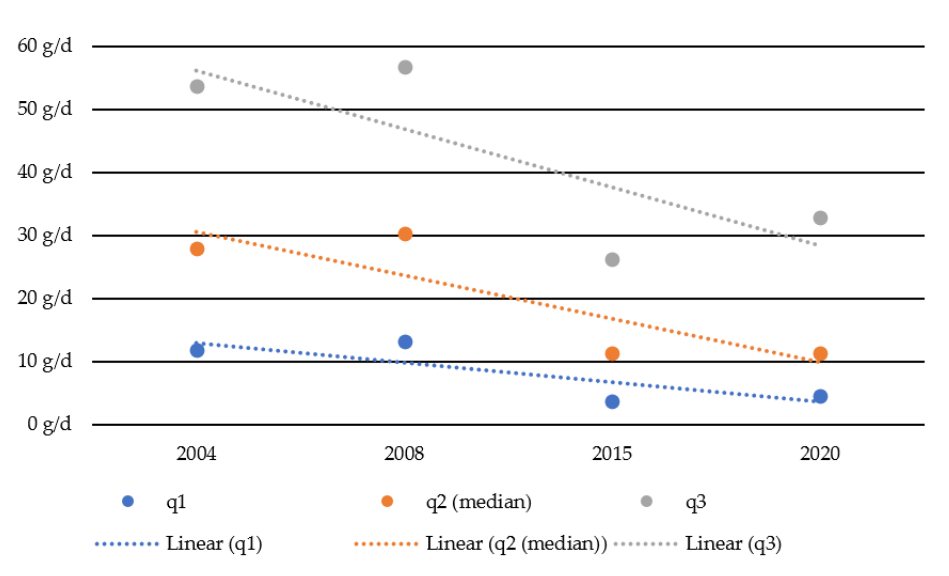
Figure 3. Quartiles of alcohol per capita consumption (g/d) among the drinking population from 2004–2020. 2004–2020.